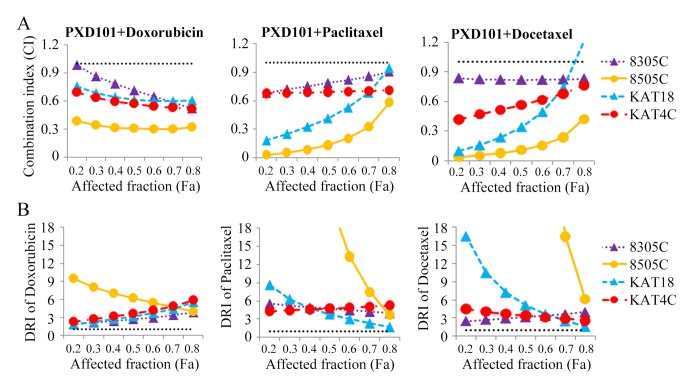
Combination treatments of PXD101 with doxorubicin and PXD101 with paclitaxel have synergistic effects against four ATC lines.A, CI of PXD101 with each chemotherapeutic agents was calculated using CompuSyn software for each ATC cell line. PXD101 plus doxorubicin and paclitaxel demonstrated synergistic effects in all cell lines, with CI < 0.8 at most conditions. PXD101 plus docetaxel was synergistic in 8305C, 8505C and KAT4C, and synergistic to antagonistic in KAT18. The horizontal dash lines at CI = 1 were drawn. B, the typical ranges of DRI values for chemotherapy in combination with PXD101. With the presence of PXD101, doxorubicin, paclitaxel and docetaxel all had favorable DRI. The lowest DRI of doxorubicin, paclitaxel and docetaxel all appeared in KAT18 (1.8, 1.5 and 1.6, respectively). The horizontal dash lines at DRI = 1 were drawn.